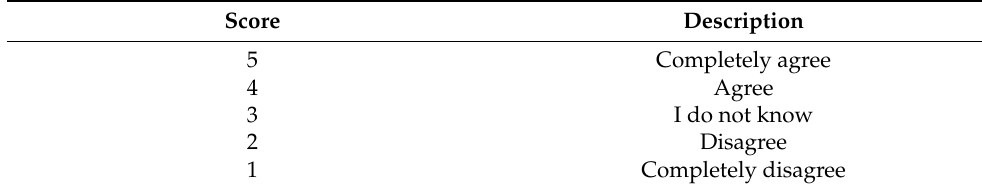
Table 1. Scores and meaning assigned to the items according to a 5-point Likert scale.